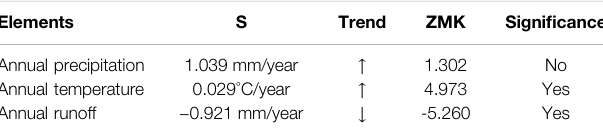
Frontiers in Earth Science |